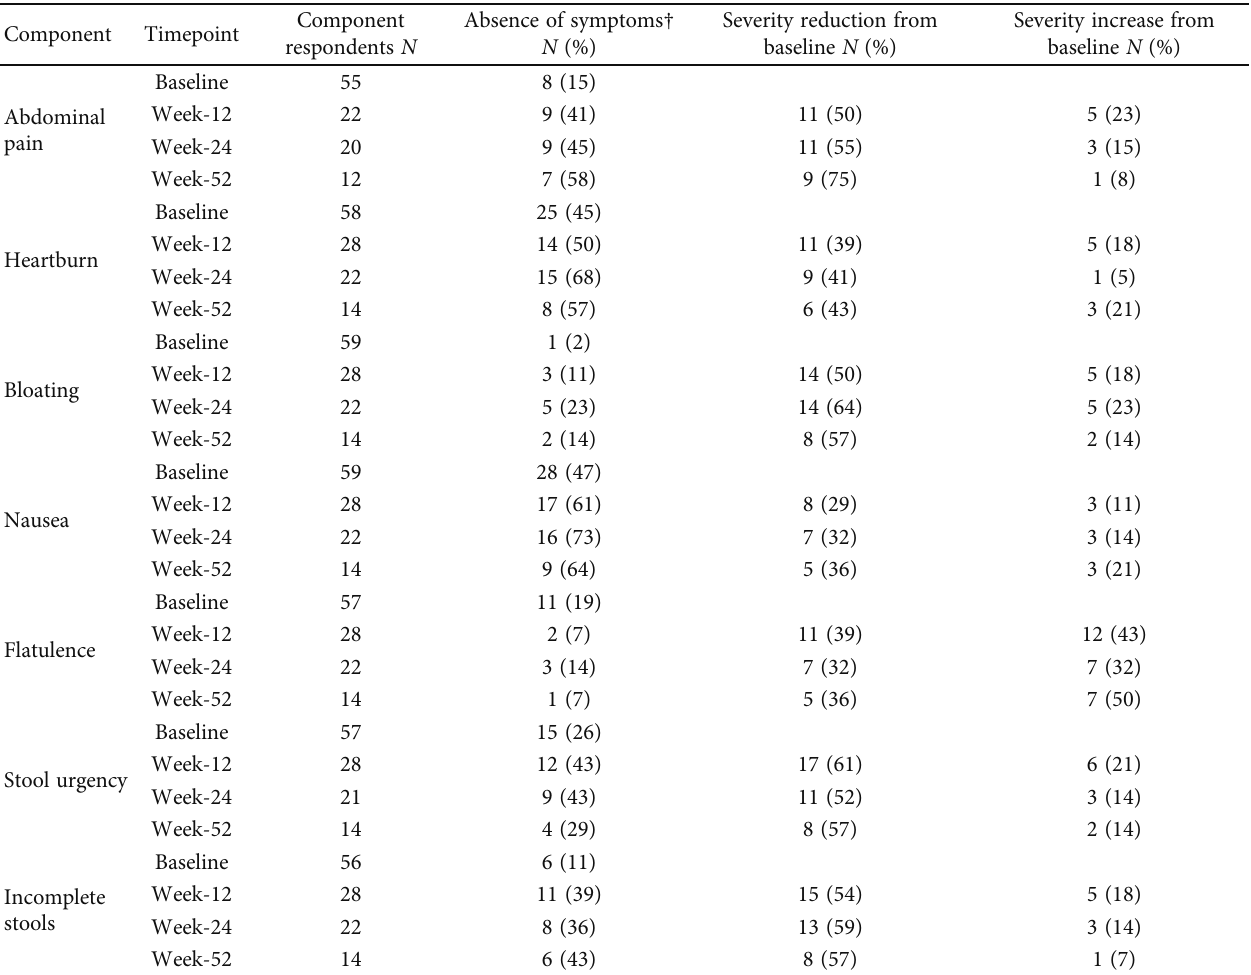
Table 3: Descriptive summary of abdominal symptom scores across baseline, week-12, week-24, and week-52 ( N = 59 ).